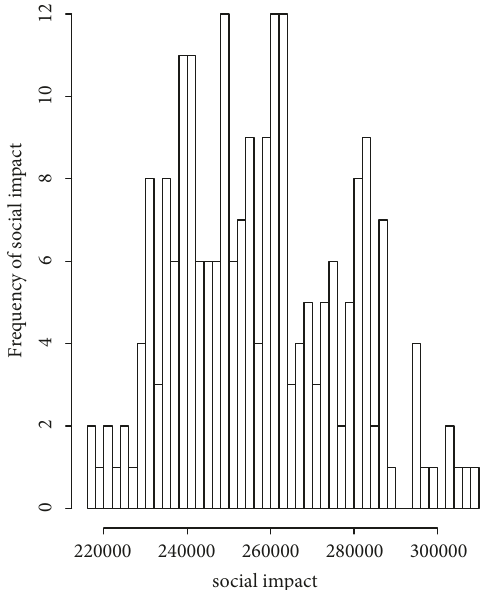
Figure 12: Distribution map of social impact,